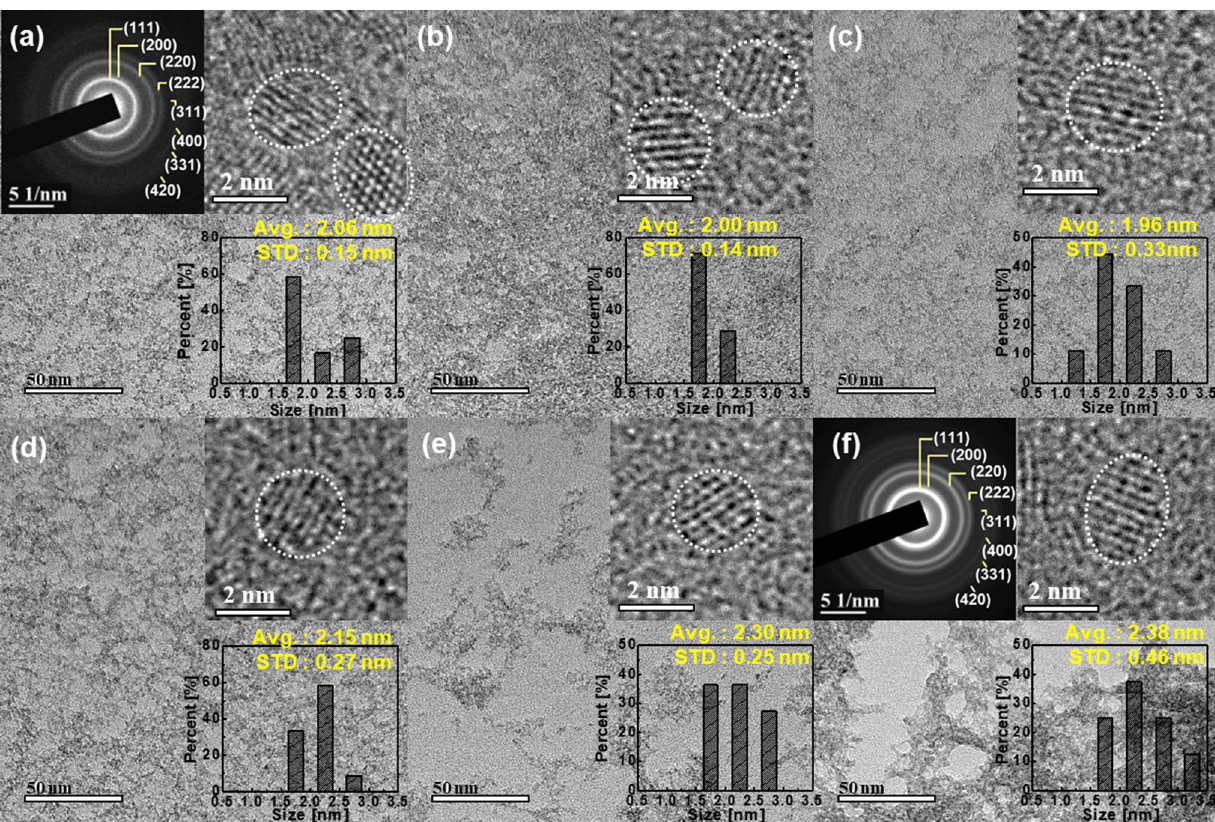
Figure 3. High-resolution TEM images of super-fine wet ceria abrasives with synthesis termination pH values of ( a ) 4.0, ( b ) 4.5, ( c ) 5.0, ( d ) 5.5, ( e ) 6.0, and ( f ) 6.5. The background TEM images were obtained at a 50-nm scale (lower left), whereas the TEM images in the insets of the figures (upper right) were observed at a 2-nm scale. In addition, a μ -crystalline diffraction pattern of super-fine wet ceria abrasives were presented in the inset of the figures (upper left), shown in Fig.